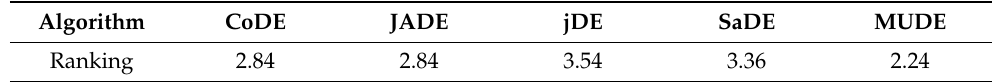
Table 3. Average ranking based on Friedman’s test.